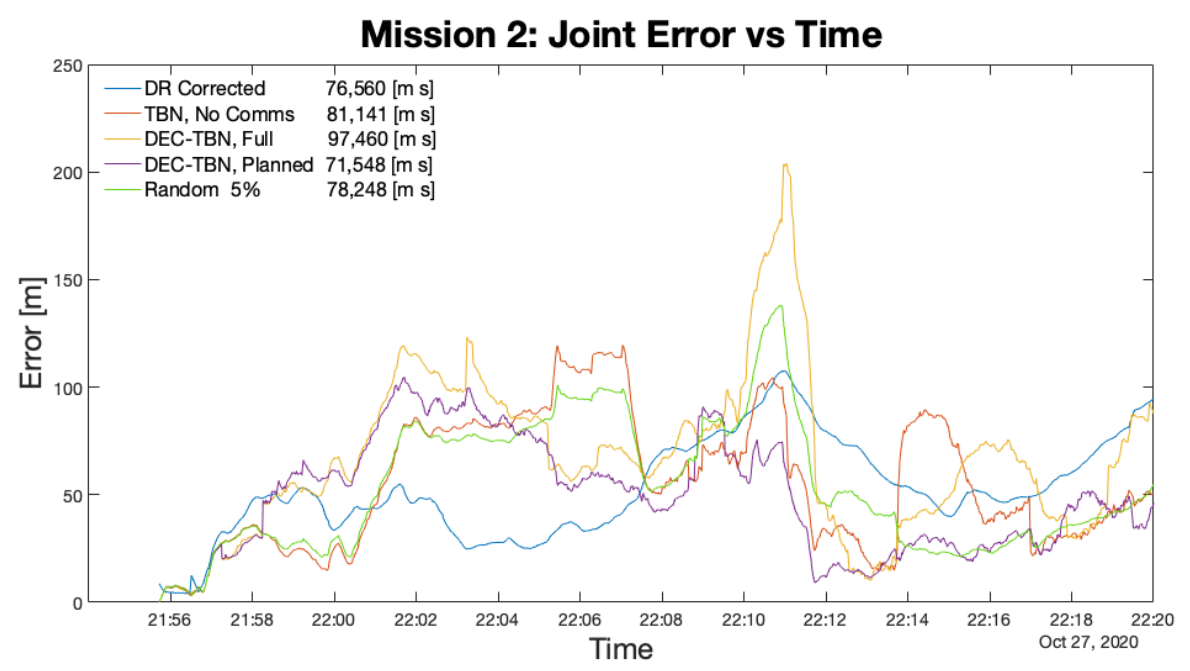
Figure 13. Joint Error for Mission 2. The spike in DEC-TBN, Full Comms. at 22:10 is indicative of a negative feedback loop from communicating erroneous localization data.